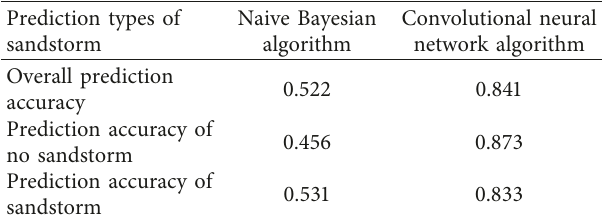
Table 7: Experimental results.